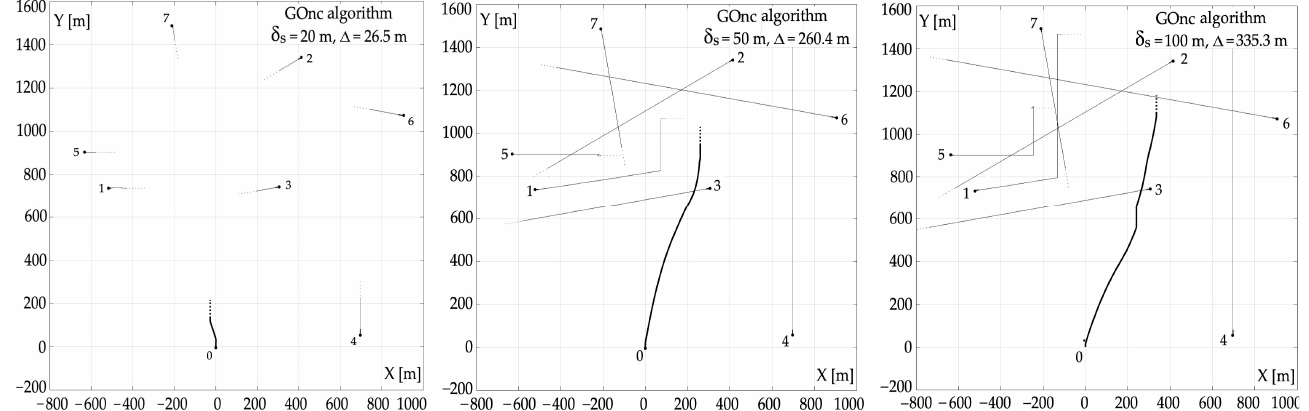
Figure 10. Safe game trajectory of our autonomous vehicle in multidirectional traffic when passing seven other non-cooperating autonomous vehicles for three safe passing distance values.